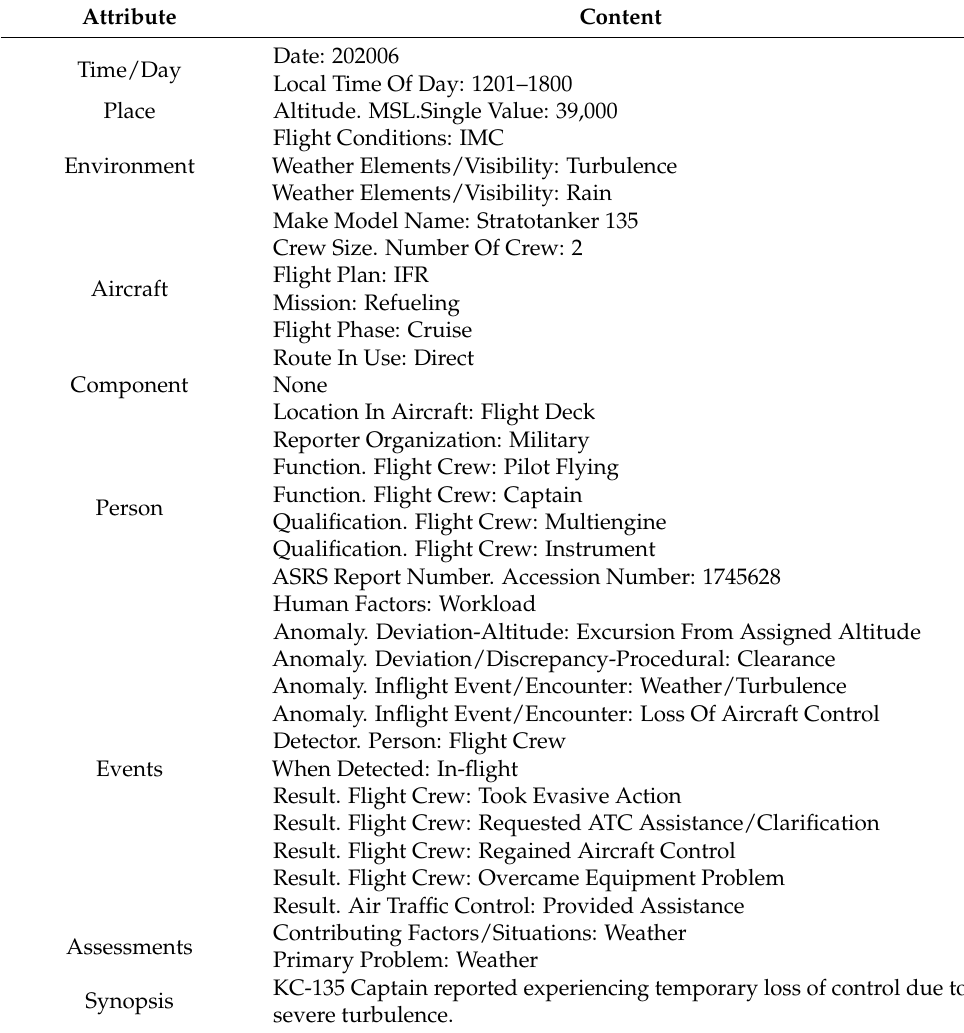
Table 1. An example of the safety report taken from